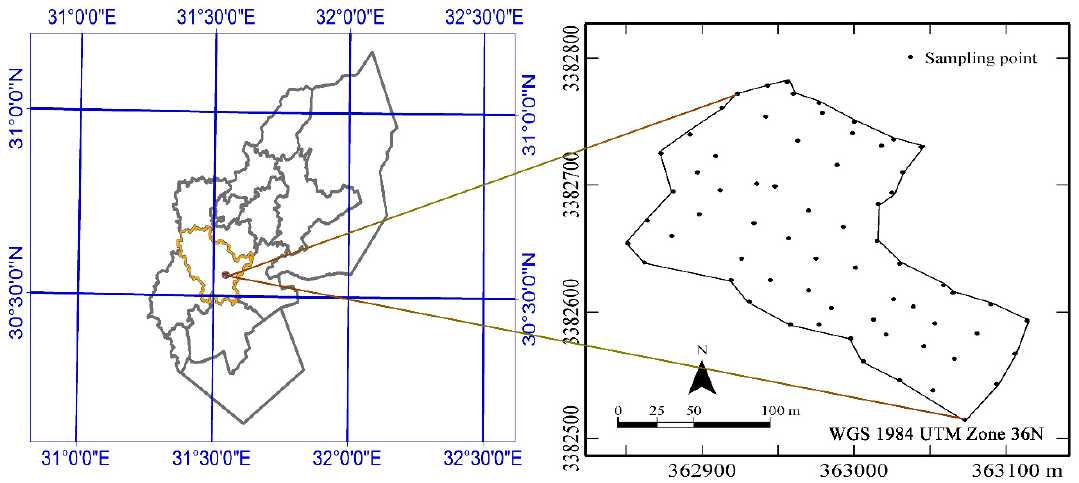
Figure 1. Location of study area and soil sampling scheme.